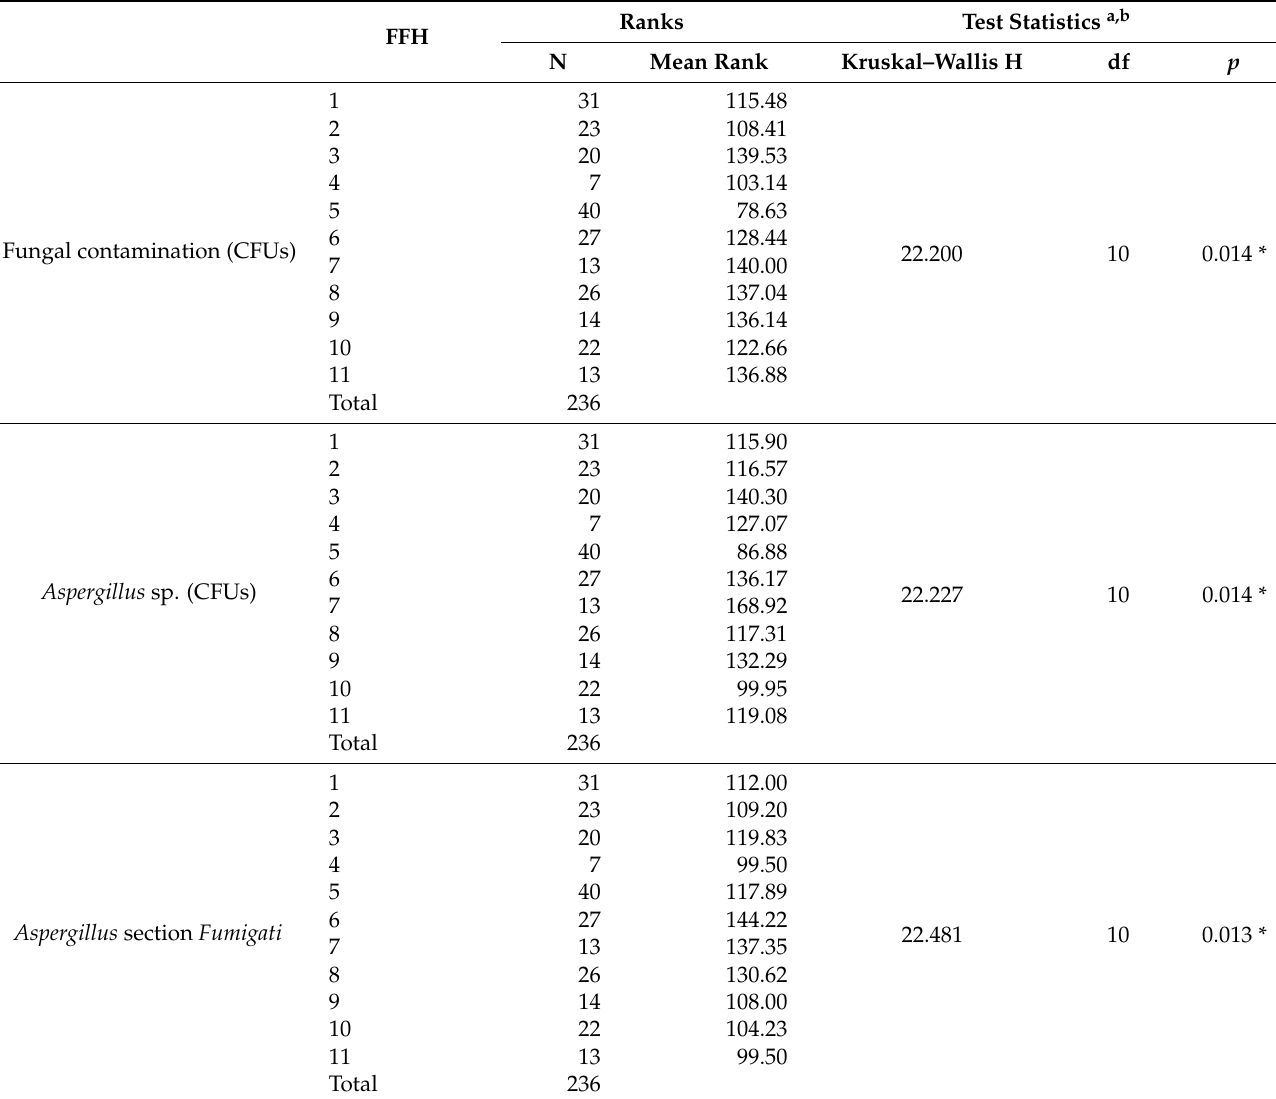
Table 7. Comparison of fungal contamination, Aspergillus sp. and Aspergillus section Fumigati between FFHs. Kruskal– Wallis test.